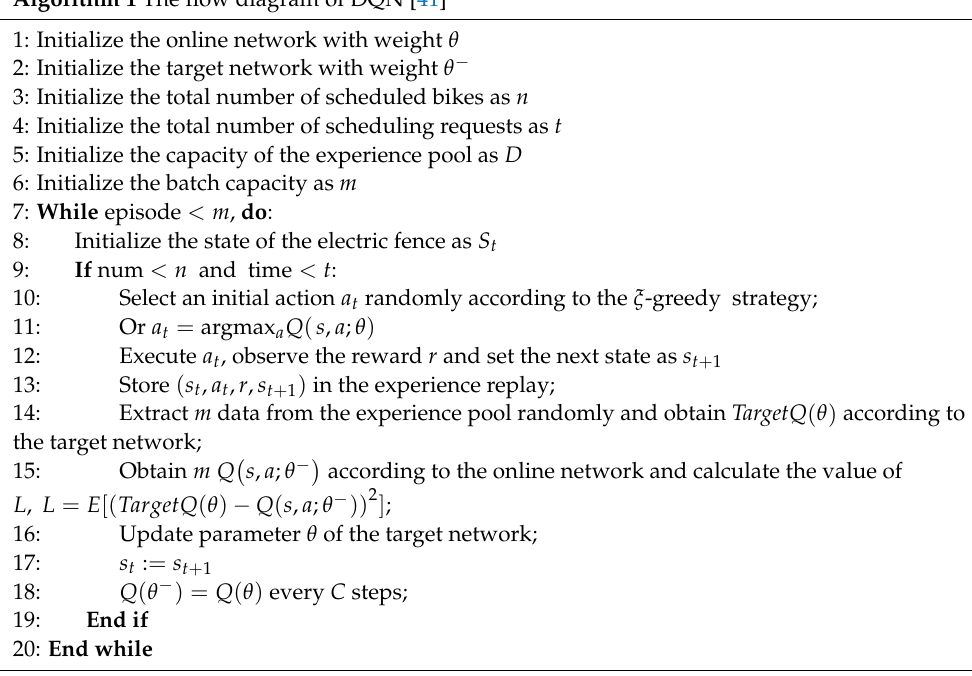
Figure 4 is the flow chart of the electric fences’ training and scheduling processes. The